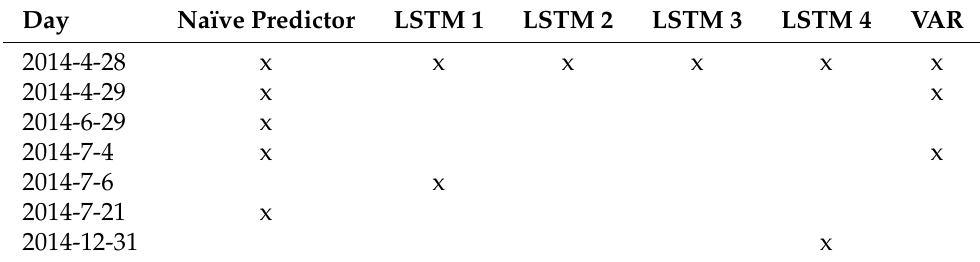
Table 2. Results: Outliers. Days that are manually classified as outliers due to high deviations in water consumption prediction from true water